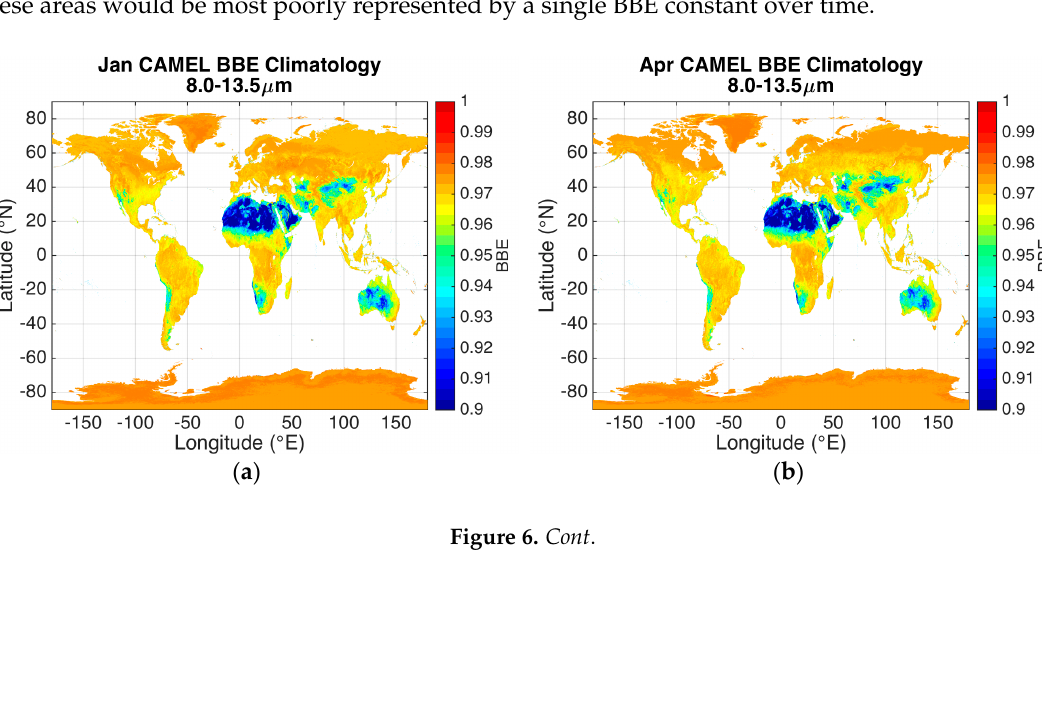
( d ) Figure 6. Monthly climatology of CAMEL 8.0–13.5 µm BBE over 2000–2016 for the month of ( a ) January; ( b ) April; ( c ) July and; ( d ) October. Figure 7. Standard deviation of monthly, 8.0–13.5 µm CAMEL BBE over the years 2000–2016 highlights geographic regions which have larger temporal variations in BBE. 4.2. BBE by Land Type and Climate Regime To further investigate how BBE changes with surface cover type, statistics are calculated over IGBP land cover classifications listed in Table 3. To calculate the statistics, IGBP categories are mapped to the CAMEL 0.05° resolution latitude and longitude grid. Since the IGBP categories are